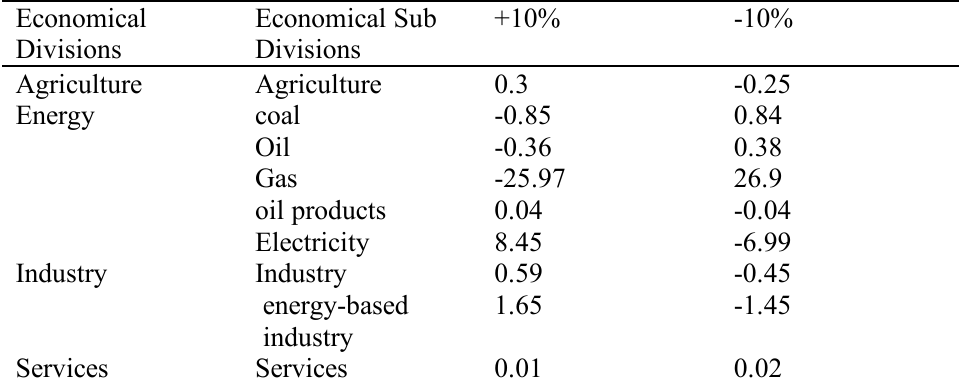
Table 2. The Carbon Footprint Situation on Export of Various Economical Divisions